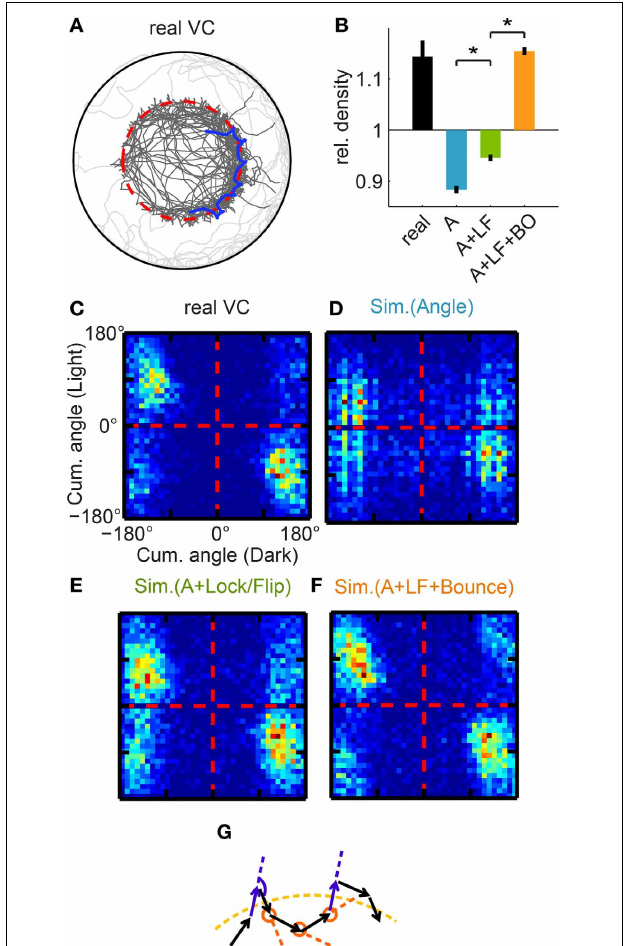
FIGURE 4 | Affinity to the virtual border. (A) Trajectory of a real fish, example trajectory segment highlighted in blue. Note that the trajectory density is much higher close to the virtual border (dotted red line). (B) Quantification of the relative bout density close to the virtual border, and comparison between real fish and different simulations. Simulations are labeled by the algorithms implemented: “A” = Algorithm I [Angle], “LF” = Algorithm II [Lock/Flip], “BO” = Algorithm III [Bounce]. Reference level ( = 1) is the normalized baseline bout density if the trajectory were uniformly distributed within the Virtual Circle. (Quantification see Figure S4A ) (C–F) Correlation between the cumulative angle turned during a light interval and during the preceding dark interval, again shown by matrices as in Figure 3B . (C) For real fish, strong clustering is shown close to the “flip” diagonal. (D) For the simulation with Algorithm I [Angle], there is no strong “lock”/“flip” bias. (E) In the simulation including Algorithm II [Lock/Flip], clustering in the “lock” quadrants is stronger than for real fish. (F) In the simulation including Algorithm III [Bounce], the simulated fish are constrained to match the “flip” pattern of real fish, and the resulting matrix confirms that the similarity to real fish is achieved. As shown in the last bar of (B) , the addition of this algorithm restores the high bout density of real fish in the simulation. (G) Illustration of Algorithm III [Bounce]. If the fish exits the virtual border at approximately the same angle (relative to the border) each time, the fish may frequently cross the virtual border. That would require the heading direction of the two purple bouts to be approximately parallel, and the angle of the turn in dark (marked with the purple arc) should have equal magnitude but opposite direction as the sum of the 3 following turns in light (marked with orange circles). ∗ p < 0 .